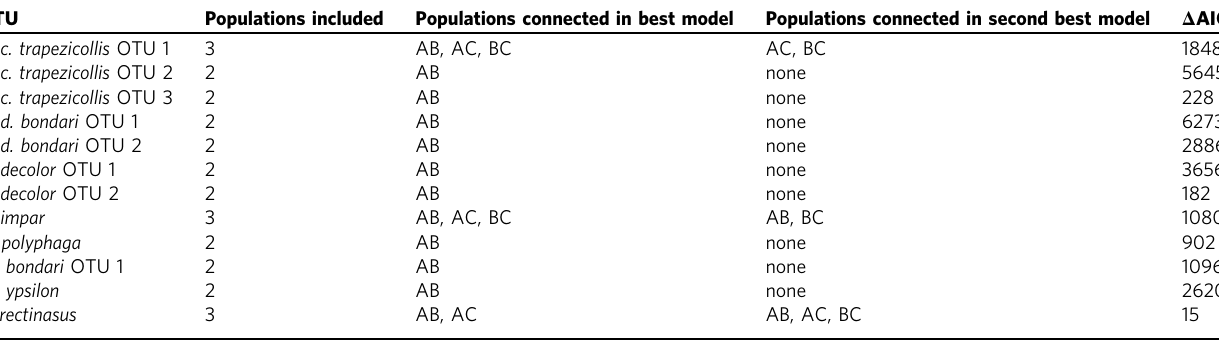
Population labels follow Fig. 1, full table with inferred parameters in Supplementary Table